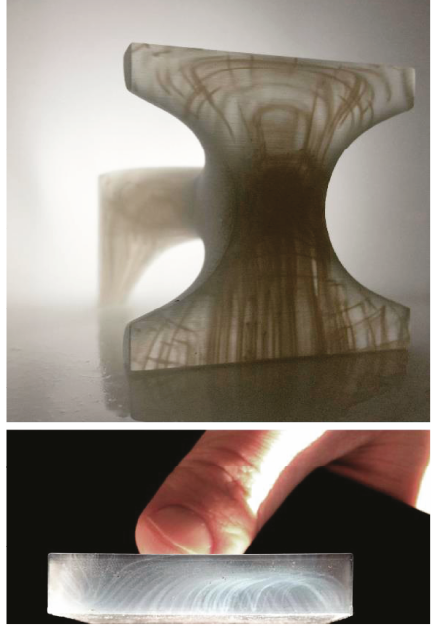
Figure 11: Printed structures modeled withvoxel-based method